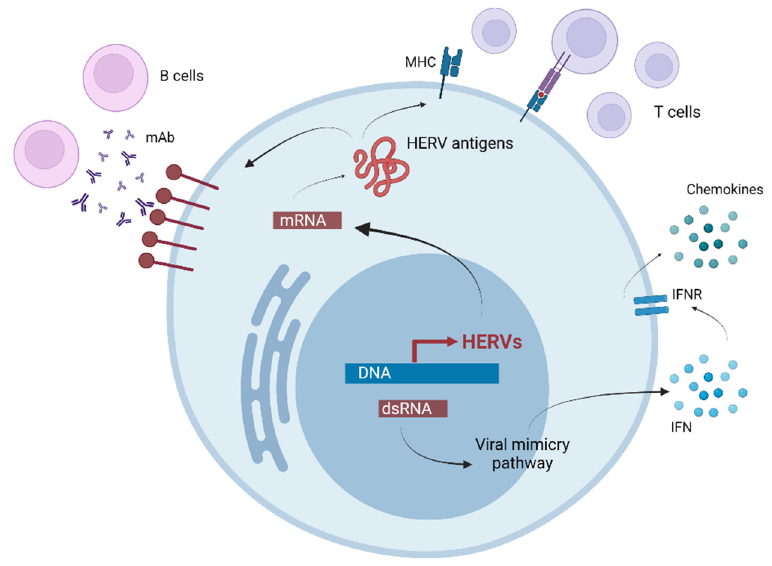
Figure 4. Some pathways of active HERVs. HERV—human endogenous retrovirus, MHC—major histocompatibility complex, mAb—monoclonal antibody, IFN—interferon, IFNR—IFN receptor.